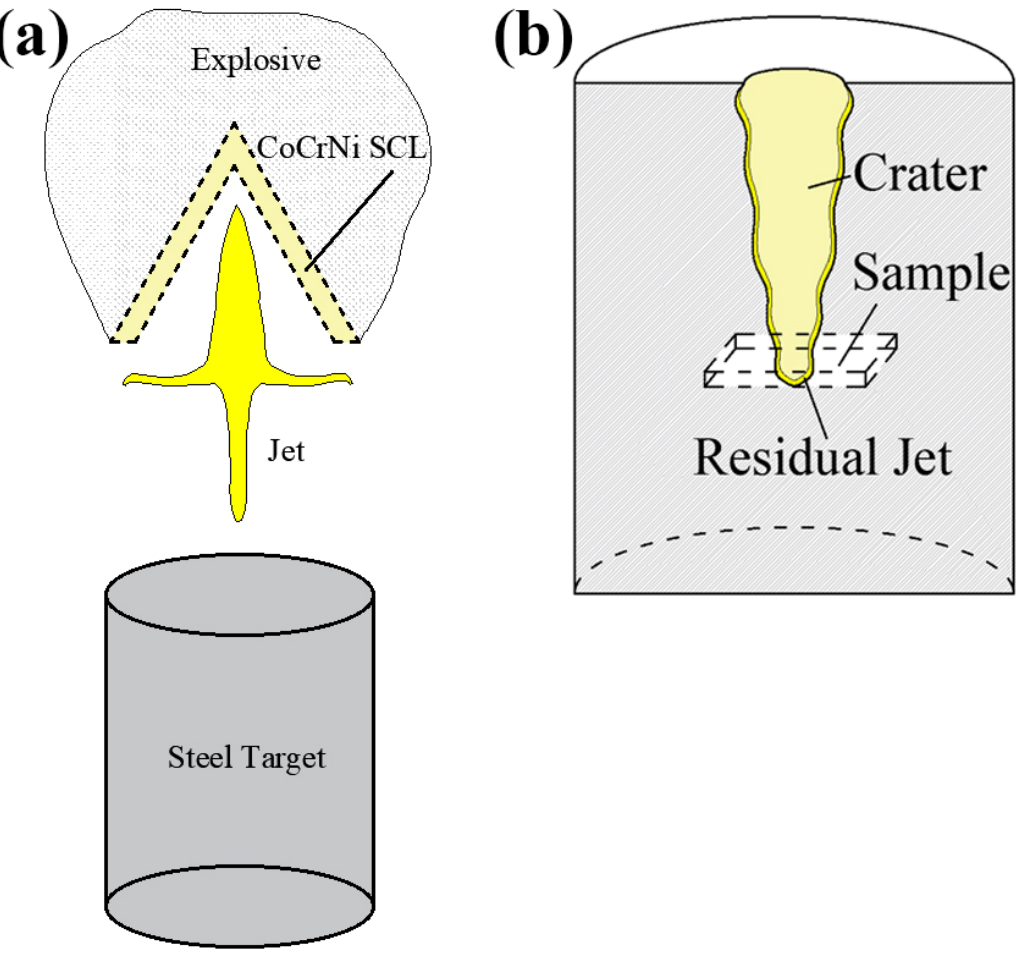
Figure 1. Schematic diagram of the CoCrNi shaped charge scheme ( a ) and the cross-section of half of the recovered steel target cut along the penetration direction. The sample for later microstructure characterization is marked by the dashed line in ( b ).